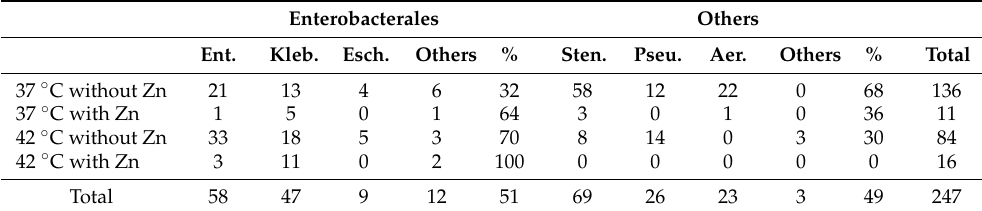
Table 3. Results of identification of genera of meropenem-resistant colonies totaled by each incubation method.